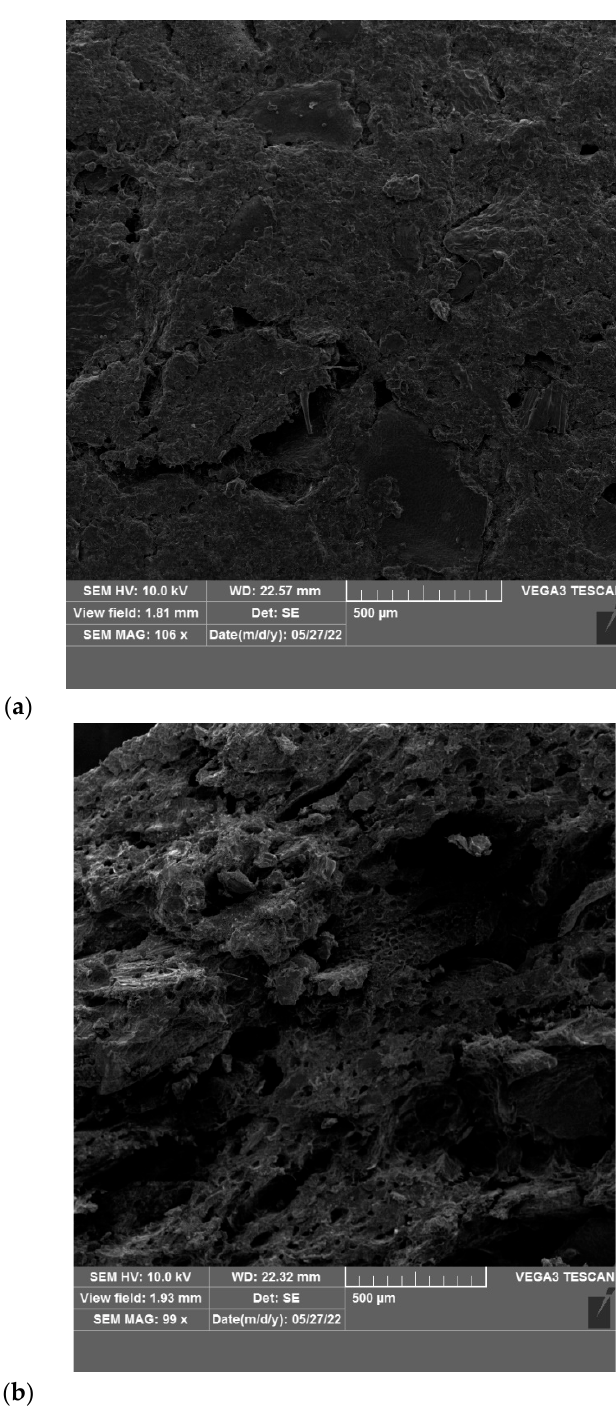
Figure 5. ( a ) The surface of the snack S4.; ( b ) the cross-section of the snack S4.